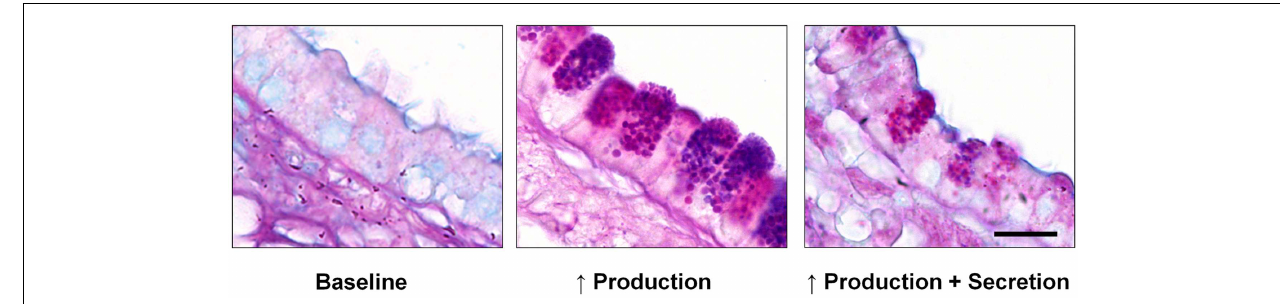
secretory cells 3days after mucin production is increased by IL-13-dependent allergic inflammation as described (51). Right – Exocytic secretion of the intraepithelial mucin stored in inflamed airway epithelium induced by brief exposure to an ATP aerosol as described (51). Scale bar is 10 µ